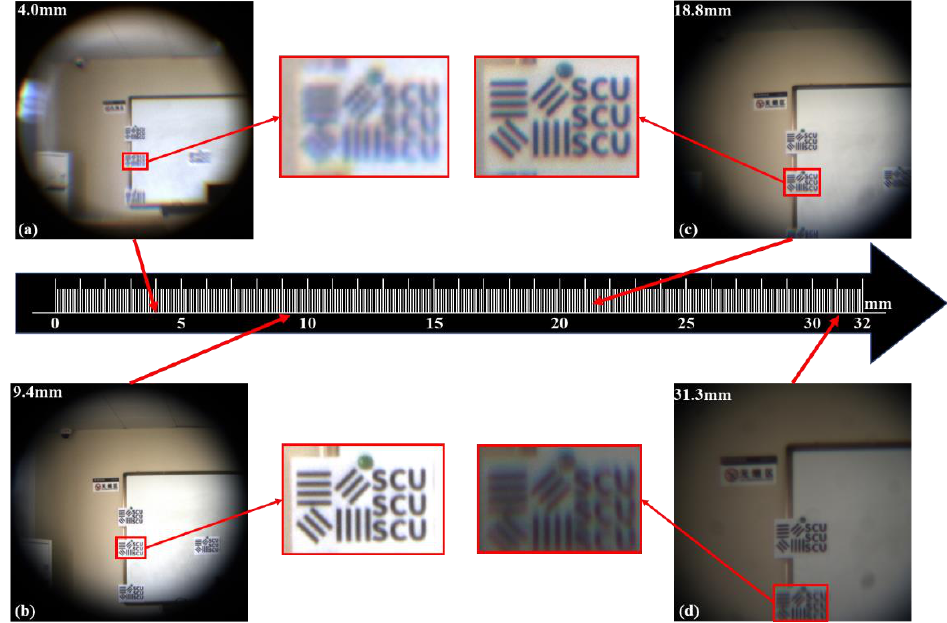
Figure 5. Images taken at different focal lengths. ( a ) f = 4.0 mm. ( b ) f = 9.4 mm. ( c ) f = 18.8 mm. ( d ) f = 31.3 mm. Table 2. Contrast ratio of the original image and the corrected image at different focal lengths. Focal length